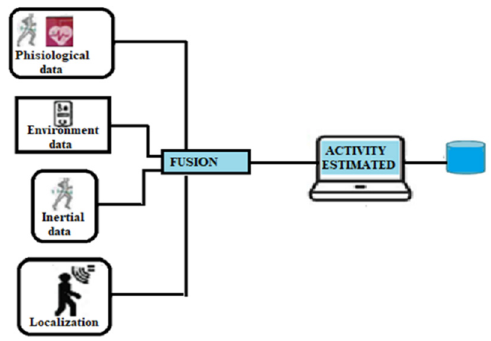
Figure 16. HAR/IPS system.